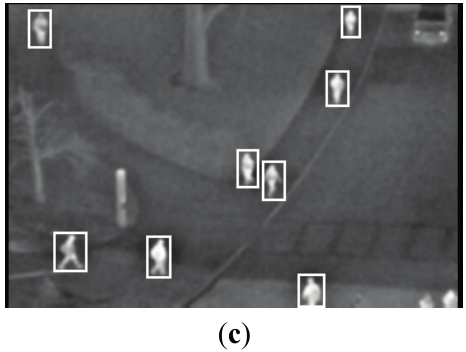
Figure 10. Result of obtaining the final region of the human area: ( a ) result after the process based on the separation of histogram information; ( b ) result after the process based on camera viewing direction and perspective projection; and ( c ) result of the final detected region of the human